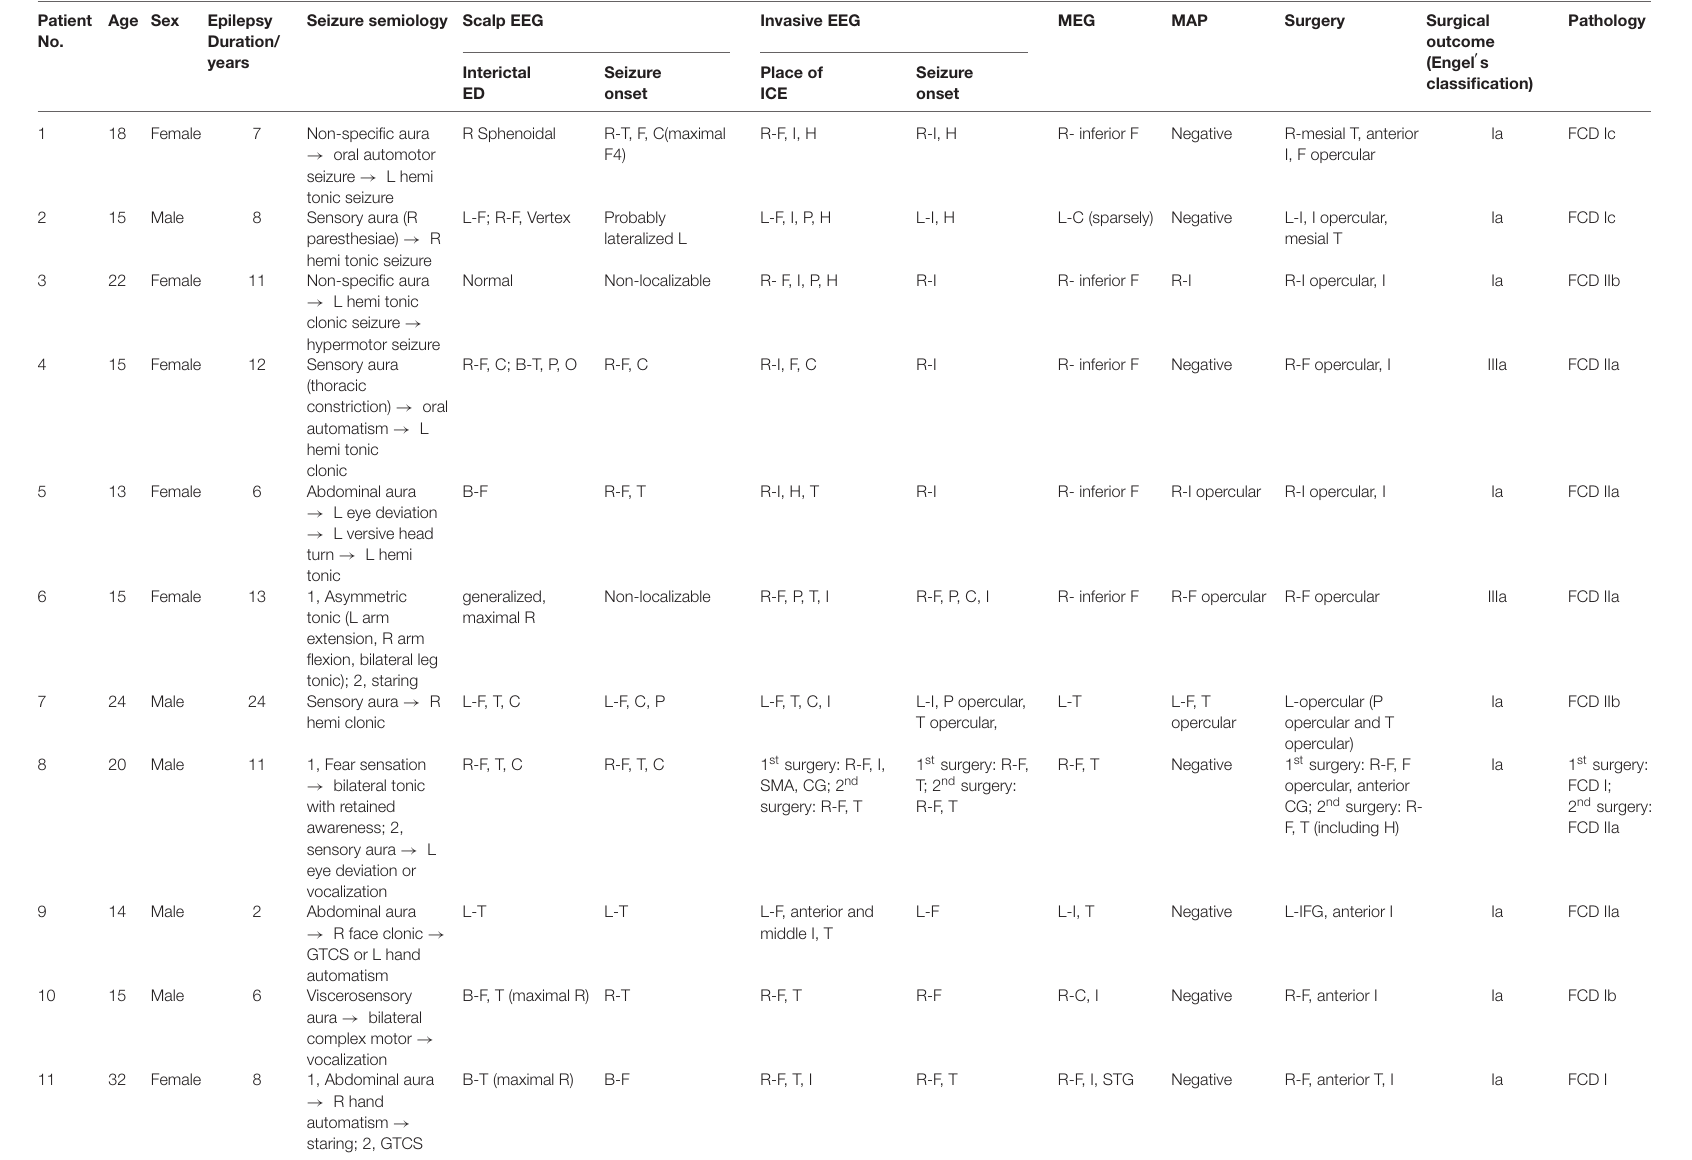
TABLE 1 | Clinical characteristics and surgical outcomes of the MRI-negative patients. Patient